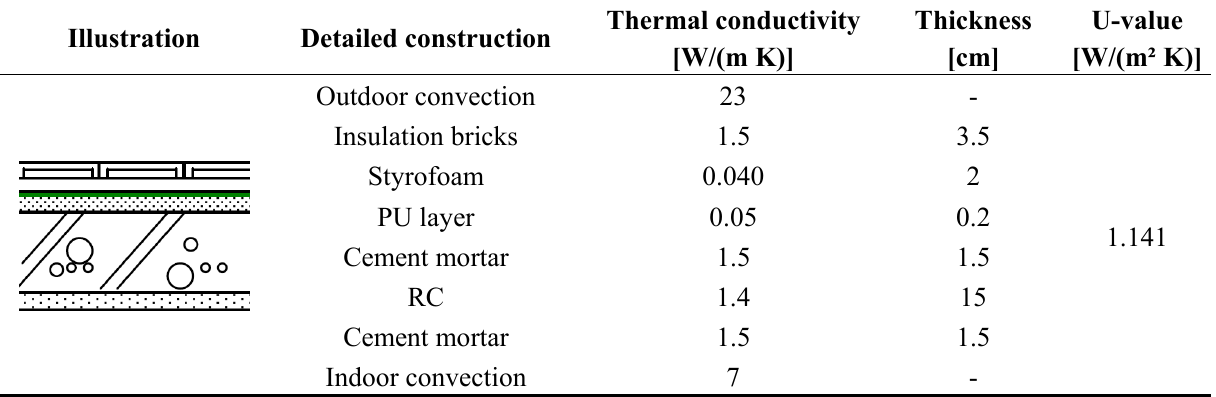
Table 1. Details of the RC roof and the thermal properties of each layer of material. Illustration